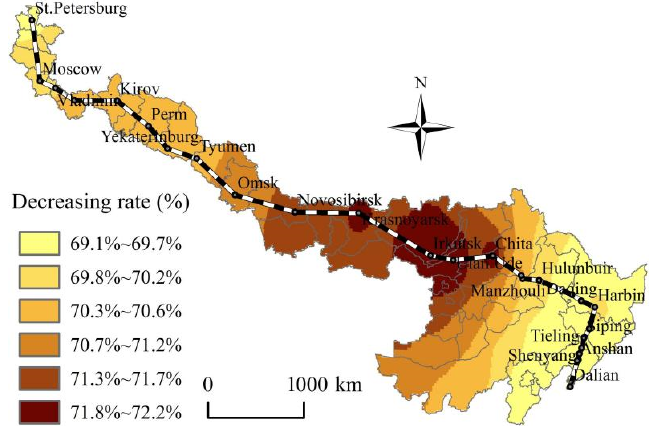
Figure 4. Spatial pattern changes of the weighted average travel time before and after the China- Mongolia-Russia HSR east line opening.